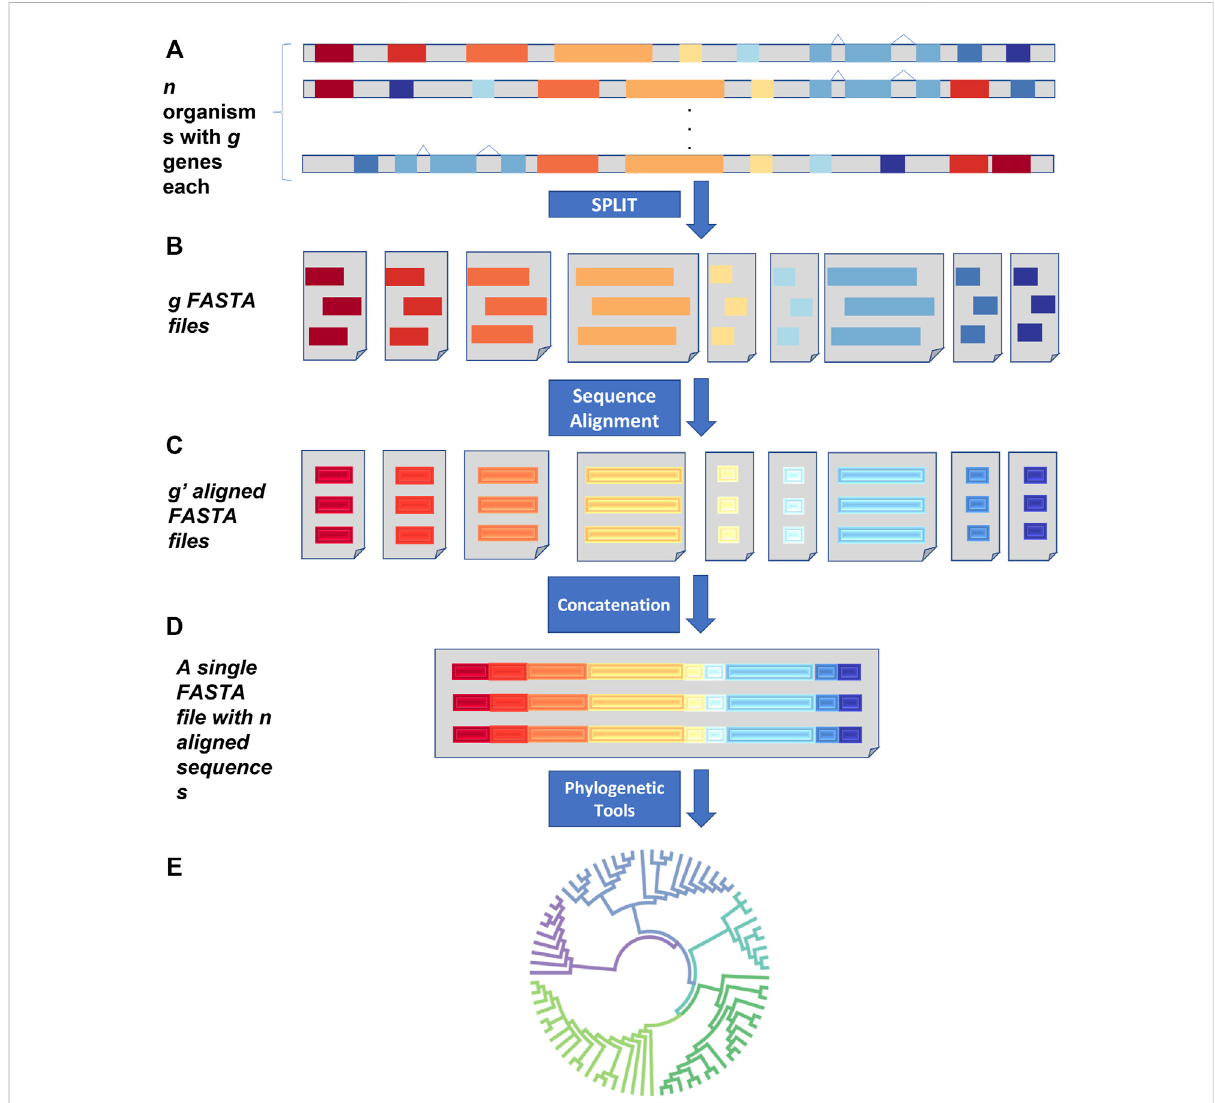
FIGURE 1 SPLACEwork fl ow. (A) SPLACEaccepts n FASTA fi lesforeachorganism containingamaximumof g genesasinput. (B) All genesweresplitinto g FASTA fi les containing the same genes from the different organisms and then aligned (C) , generating g´ -aligned FASTA fi les. (D) SPLACE then concatenates the g´ -aligned genes from the same organism, generating a supermatrix with the resulting n sequences, which can then be used to infer phylogeny (E)